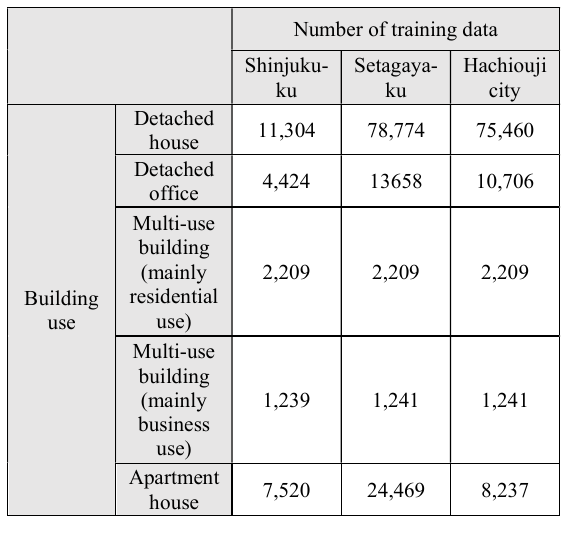
Table 4. Breakdown of training data by building use for each municipality